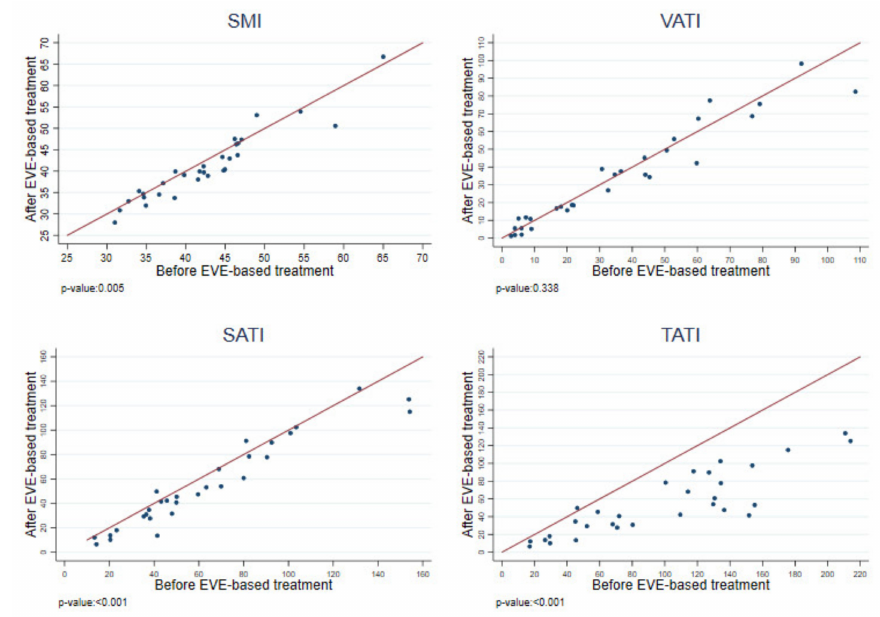
Figure 4. Indexes variation measured before and after the start of everolimus-based